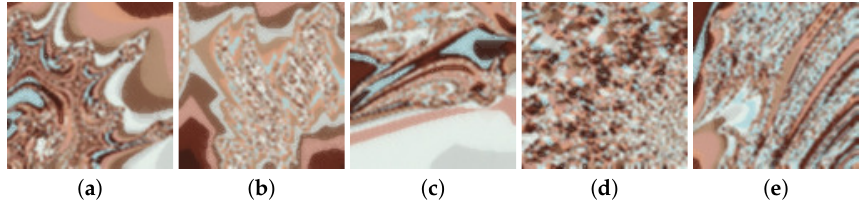
Figure 5. Fractal data sets represented in pseudocolor. ( a ) FR1 ; ( b ) FR2 ; ( c ) FR3 ; ( d ) FR4 ; ( e ) FR5